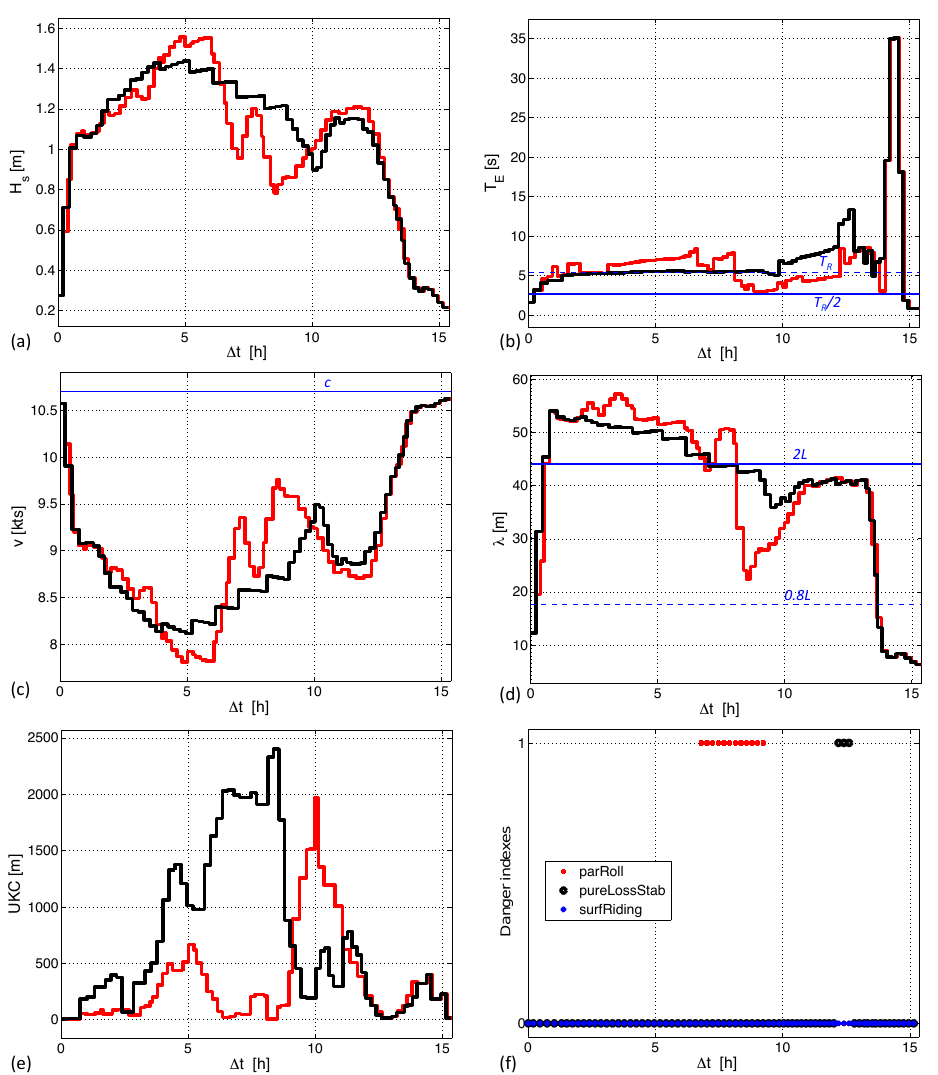
Figure 13. Case study #2. Information along geodetic (black) and optimal (red) route of Fig. 12: (a) significant wave height H s ; (b) encounter wave period T E ; (c) sustained speed v ; (d) wavelength λ ; (e) under keel clearance UKC; (f) danger indices along geodetic route, 0: safe; 1: dangerous. The quantities T R , c , L refer to vessel V2 of Table